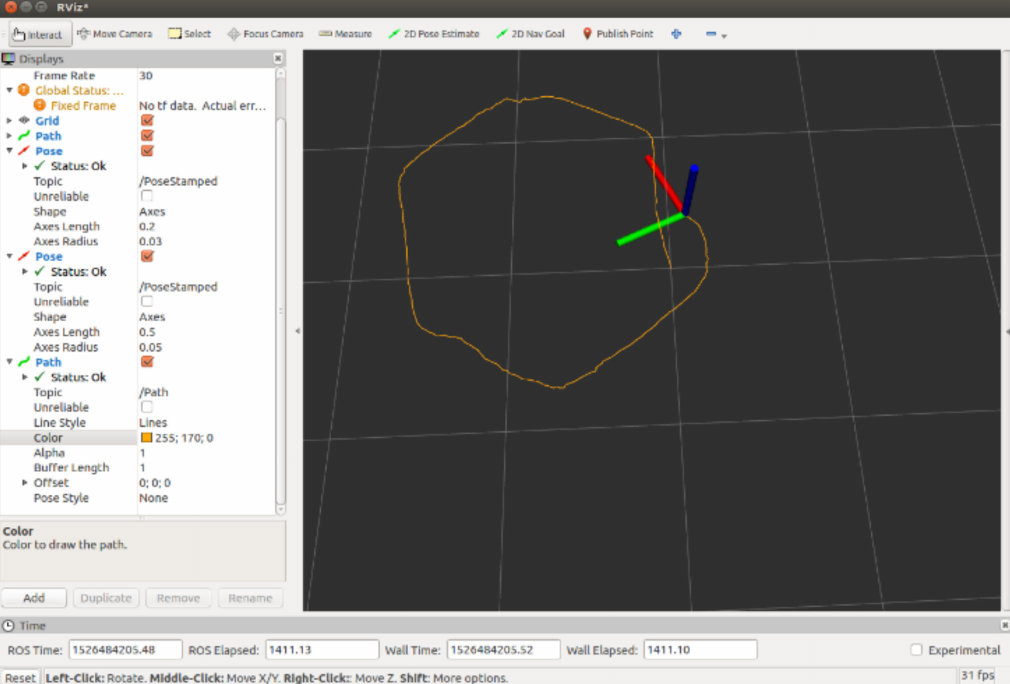
Figure 5. Trajectory of the AUV launched by RVIZ (a 3D visualizer for the Robot Operating System (ROS) framework) released by ROS